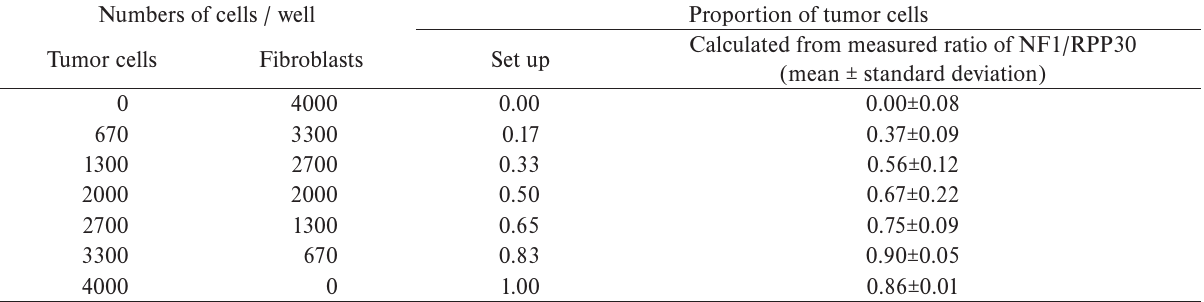
Table 1. Proportion of tumor cells: set-up and